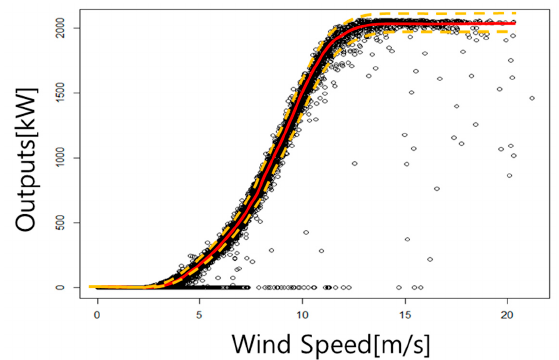
Figure 1. The wind turbine’s power curve from the manufacturer (red line), ±20% of the power curve’s values (orange dashed lines) and measured outputs (black circles) from a wind turbine located on Jeju Island.